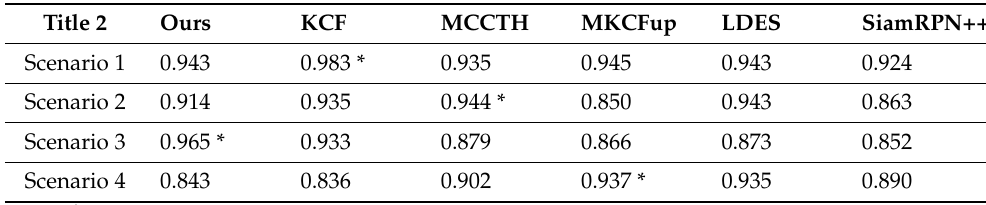
Table 1. Tracking accuracy using Metrics-1.